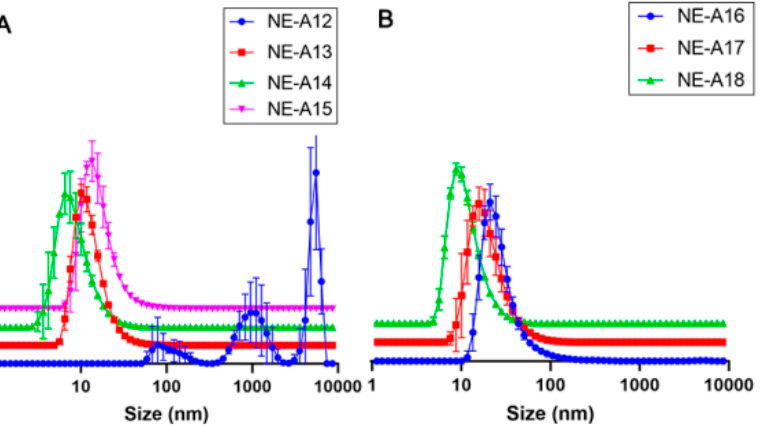
Figure 2. Droplet size distribution curves (nm) for ( A ) NE-A12 to NE-A15 and ( B ) NE-A16 to NE- A18.